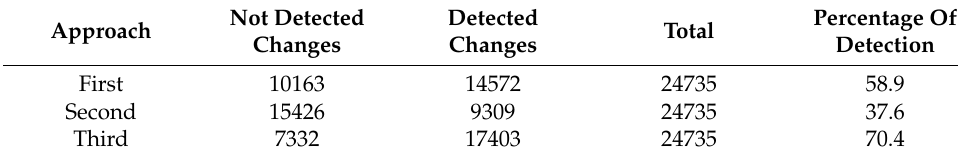
Table 3. Count of real changes with surface > 100 m 2 identified by at least one pixel.